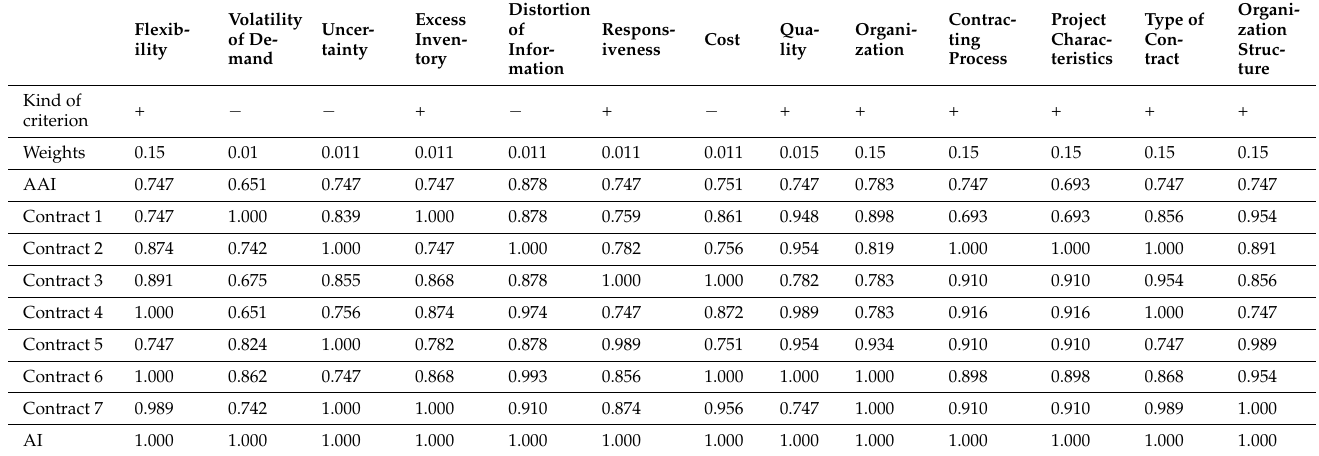
Table 13. Normalized decision matrix. + represents benefit criteria and – demonstrates cost